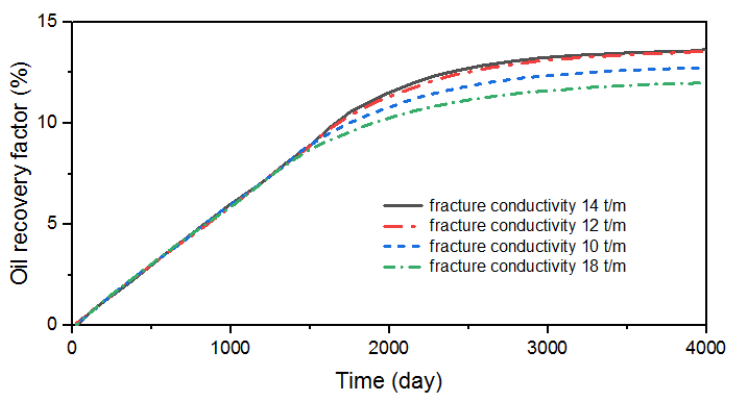
Figure 8. The comparison of oil recoveries under different fracture